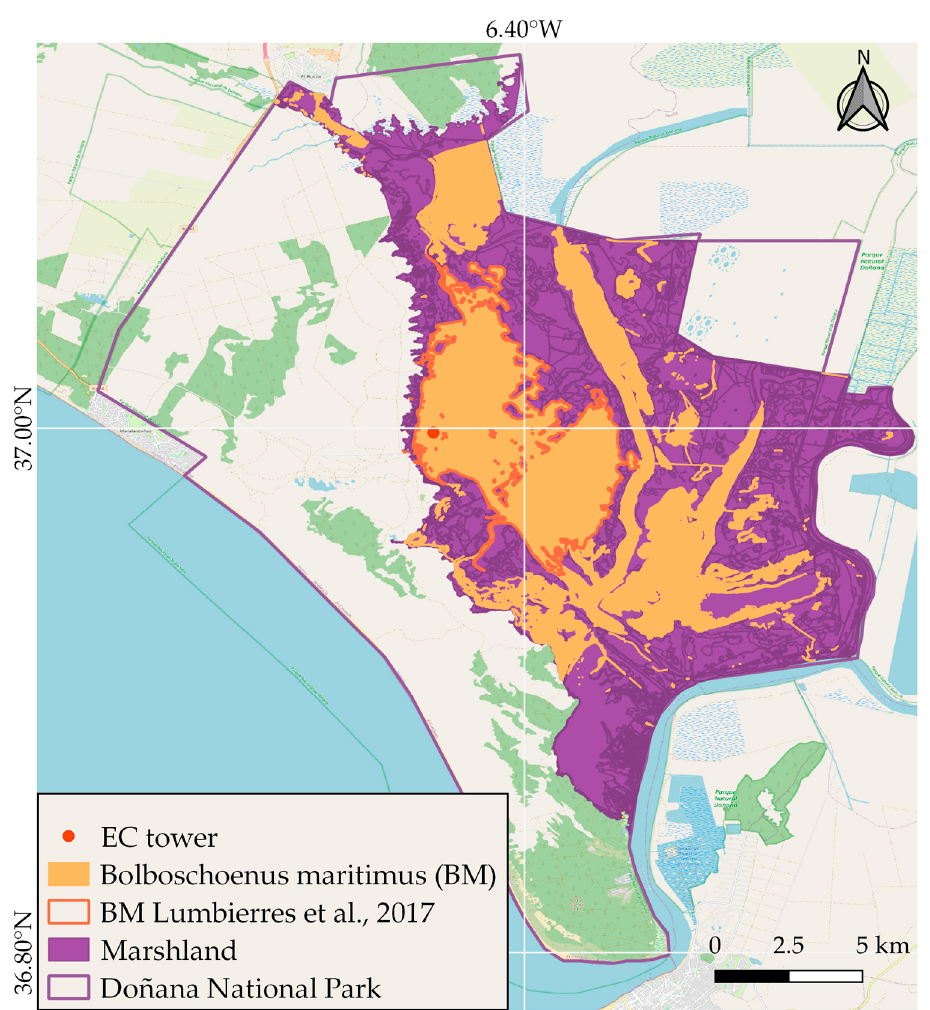
Figure 11. Vegetation classification over the Doñana park for 2009 (shapefiles provided by ICTS-RBD). The Bolboschoenus maritimus vegetation identified in 2009 is displayed in orange. The “BM Lumbierres et al., 2017” red limited area represents the Bolboschoenus maritimus dominated area identified by Lumbierres et al. [58] and used in their research on biomass production. The red limited area has been adopted in our study for the estimation of GPP in the marsh area surrounding the EC tower.